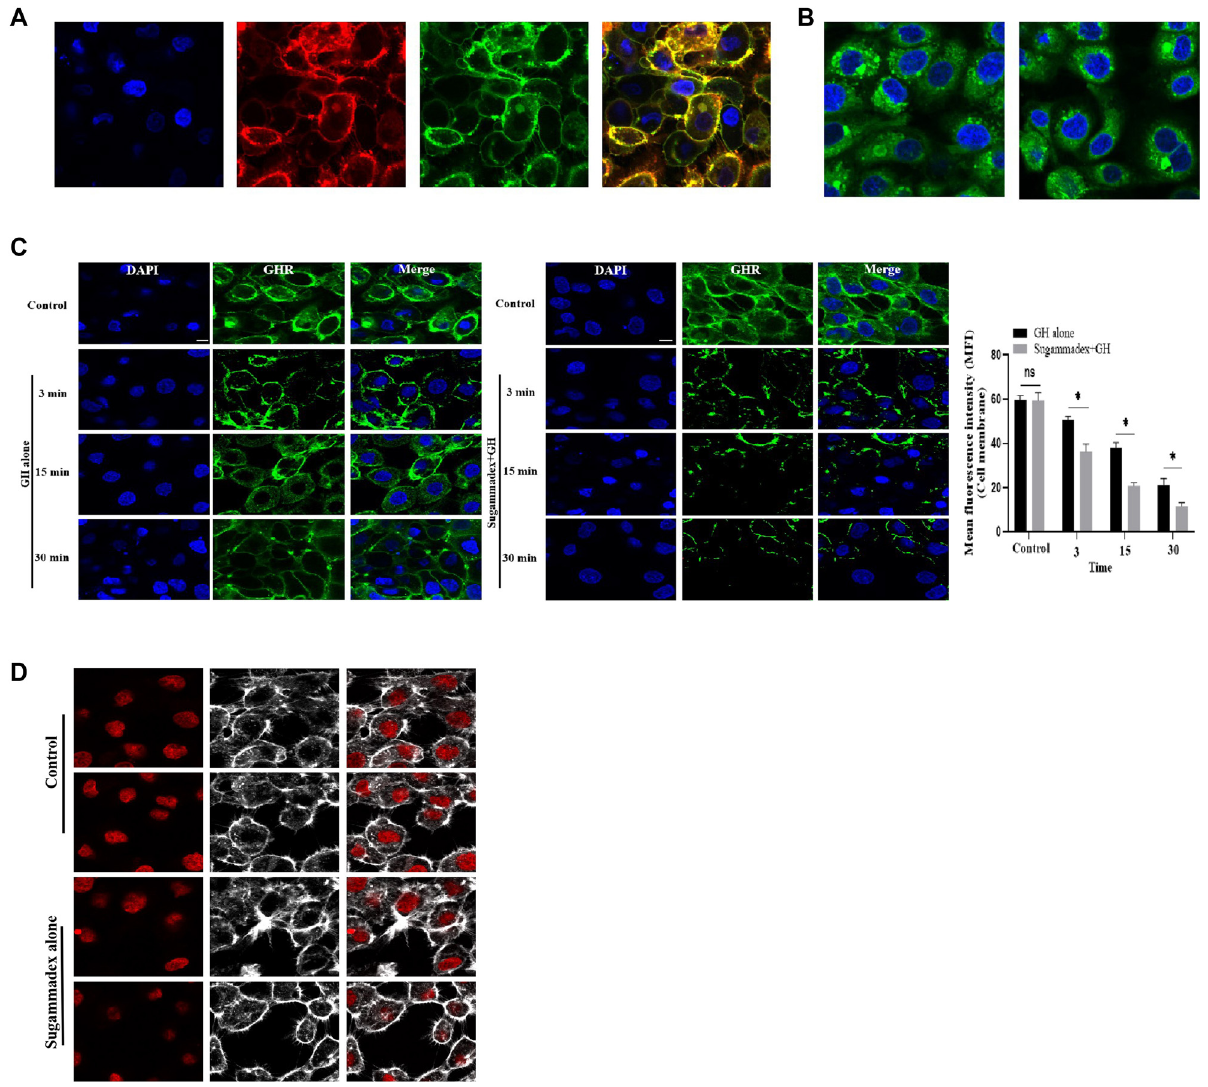
Figure 3: The molecular mechanism by which Sugammadex inhibits GH/GHR signaling pathway. (A) Sugammadex does not affect growth hormone (GH) binding to growth hormone receptor (GHR). (B) Sugammadex does not inhibit GH ’ s intracellular trafficking. (C) GHR was down-regulated by GH treatment. (D) GH-induced GHR down-regulation is accelerated by Sugammadex treatment. Sugammadex alone has no effect on GHR expression pattern by confocal laser scanning microscope (CLSM) analysis. Data are represented as mean ± standard deviation (SD). The asterisk indicates that the difference is statistically signi fi cant (p-value